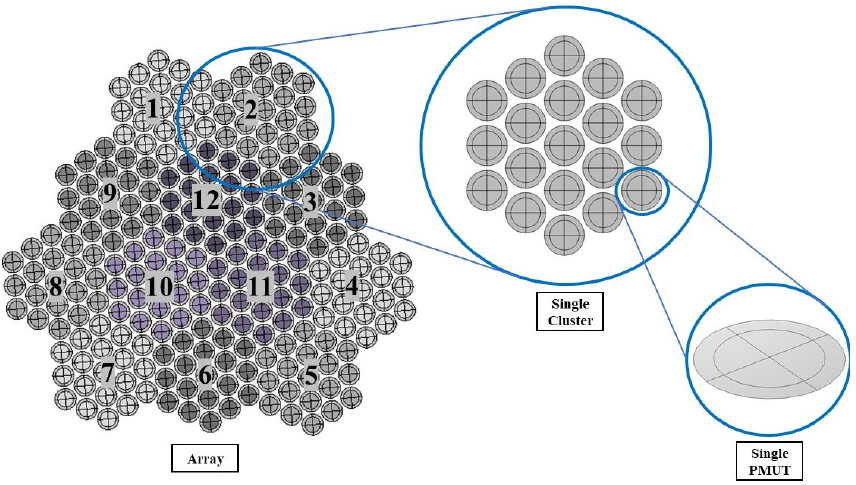
Figure 8. Configuration of the array of PMUTs